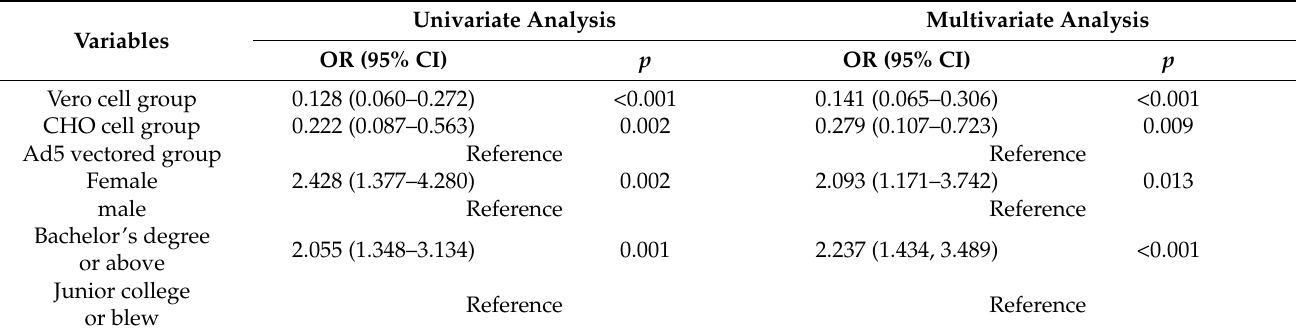
Table 3. Risk factors for AEFI following administration of different COVID-19 vaccines in HCWs.